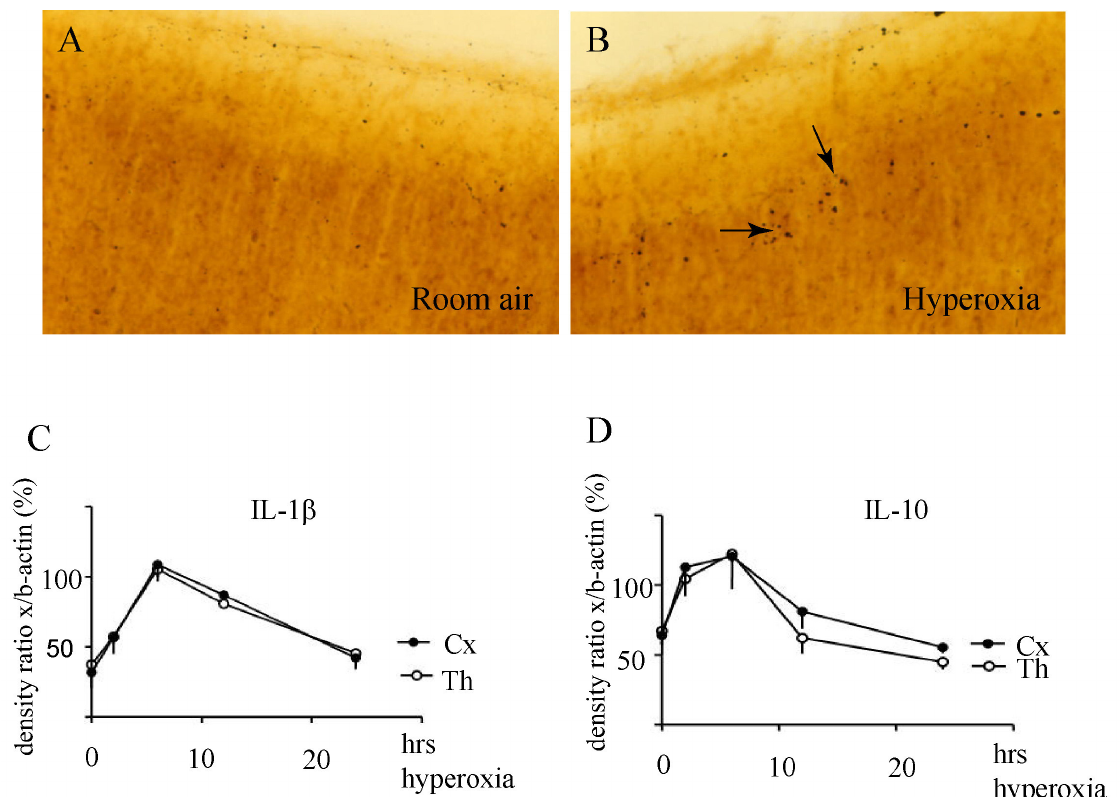
FIGURE 2. Effects of hyperoxia on cellular integrity and cytokine expression in the neonatal brain. (A,B) Cell damage indicated by silver staining (arrows) in cortex of Wistar rat pups at postnatal day 7 (P7) is increased after 24 h hyperoxia (B) compared to controls at room air (A). (C,D) Reverse transcription-quantitative polymerase chain reaction (RT-qPCR) analysis of proinflammatory IL-1 β (C) and anti-inflammatory IL-10 (D) RNA levels in two regions of the P6 brain (Th = thalamus; Cx = cortex). Both cytokines are increased during exposure to hyperoxia, showing a peak at 6 h. Gene-specific qPCR values were normalized and expressed as percent of actin values. Cytokine levels in room air controls were